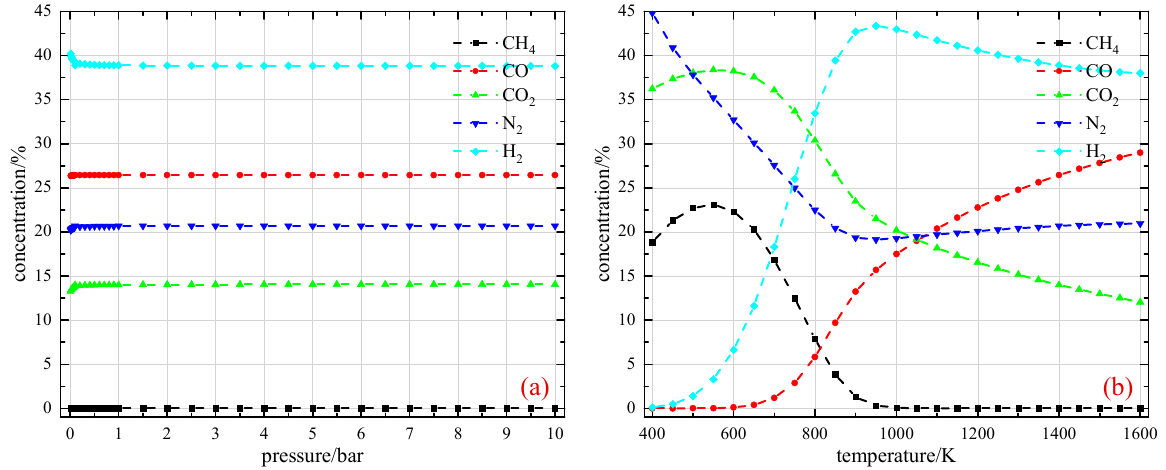
Figure 10. CEA analysis results at: ( a ) different pressures and; ( b ) different temperatures.